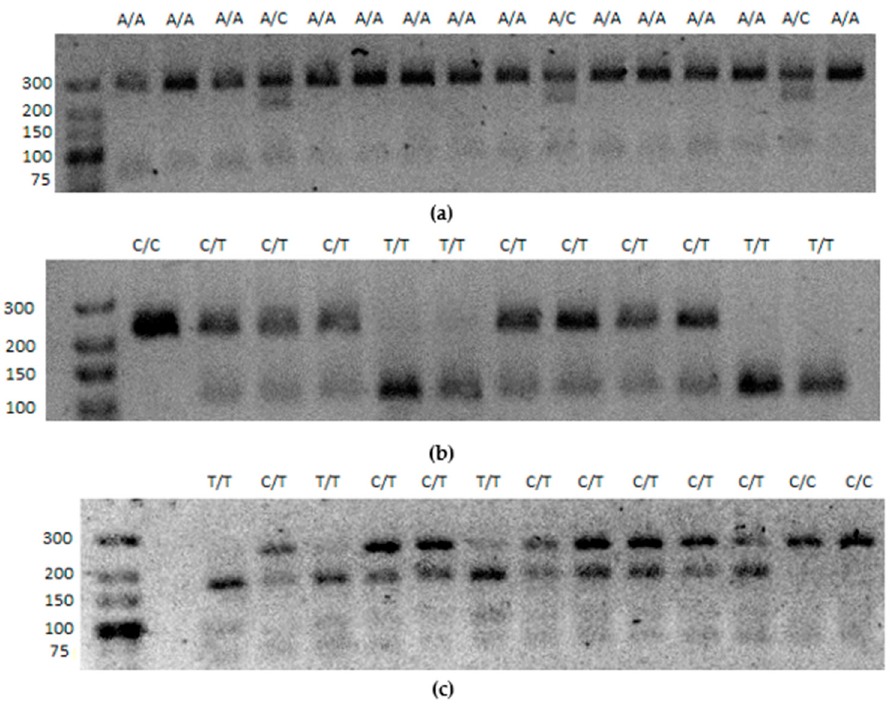
Figure A1. Examples of electropherograms used in the genotyping of: rs2234694 ( SOD1 ) ( a ), rs5746105 ( SOD2 ) ( b ), rs4880 ( SOD2 ) ( c ).